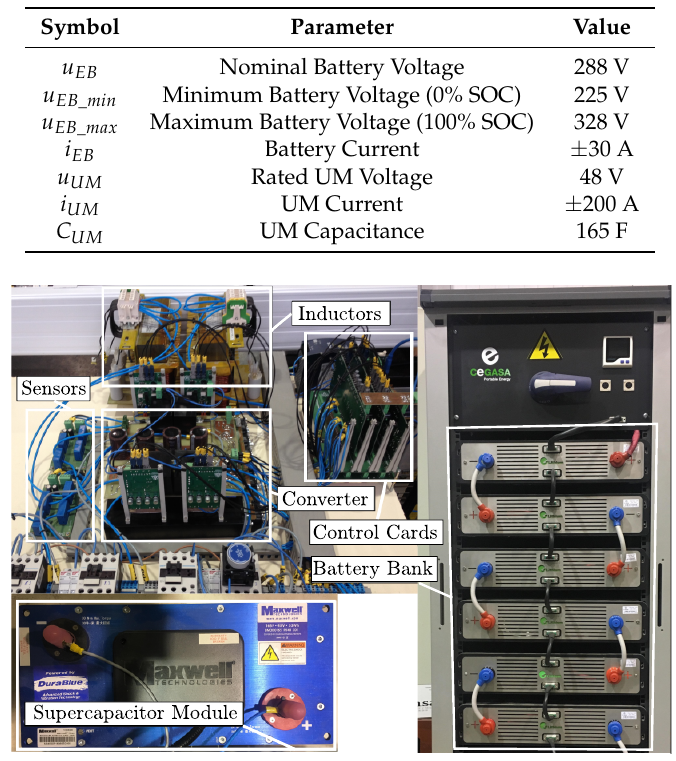
Table 1. Parameters of the 10 kW prototype.